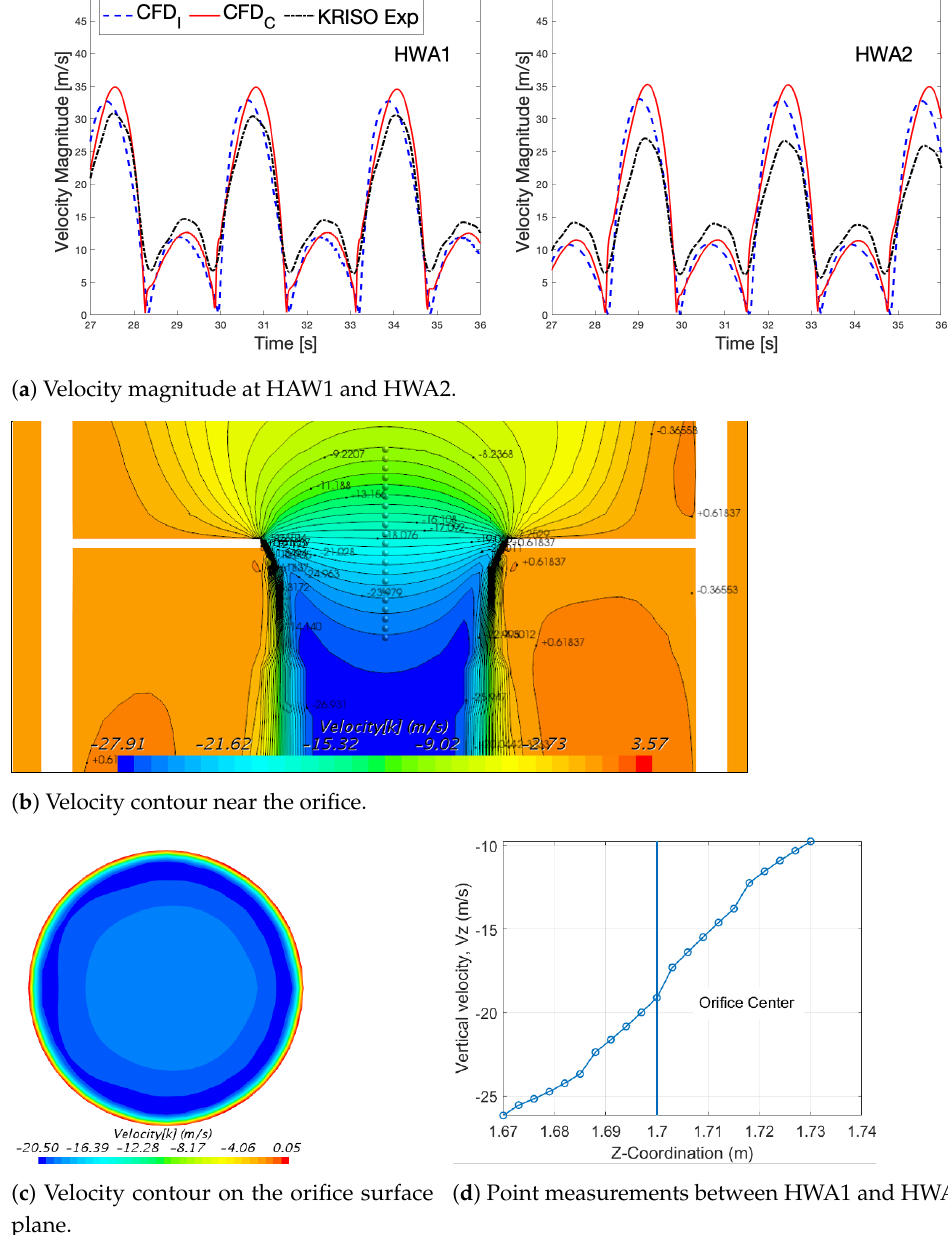
Figure 26. ( a ) Comparison of the measured and CFD simulated flow velocity at the upper (HWA1) and lower (HWA2) gauges; ( b , c ) velocity (in z direction) contour plots near the orifice; and ( d ) point measurements between HWA1 and HWA2 from the incompressible CFD simulation for Test